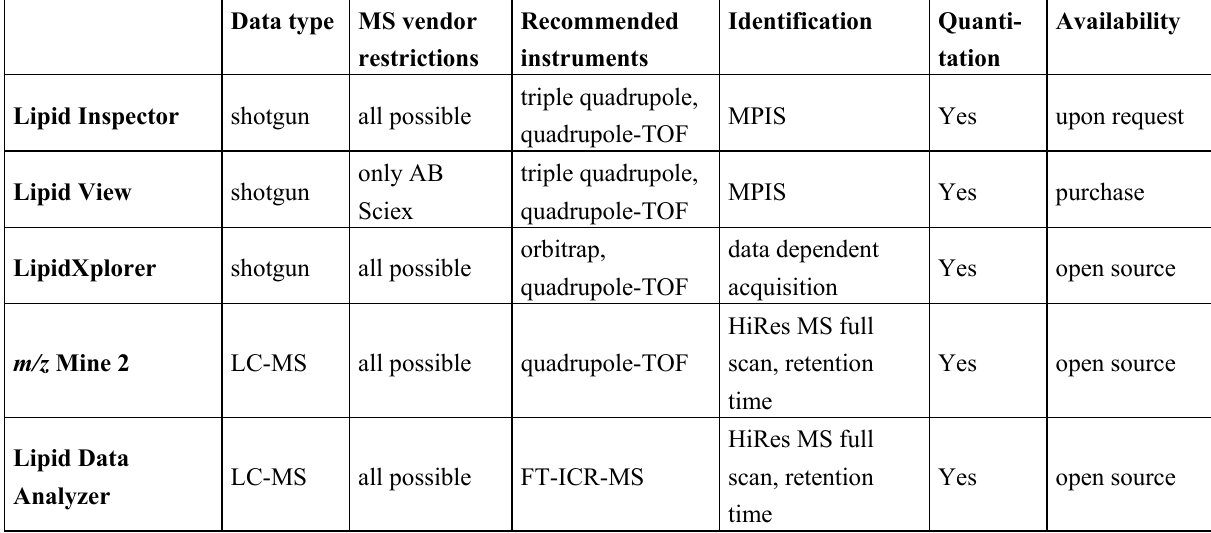
Table 1. Overview about various lipidomic data processing software